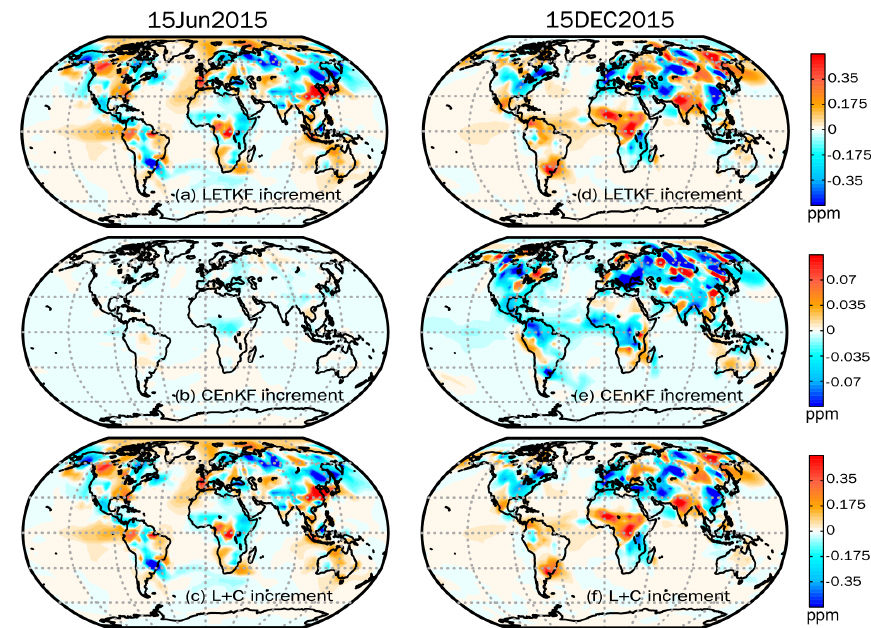
Figure 12. The ensemble mean LETKF and CEnKF increments of the surface CO 2 on 15 June 2015 (a–c) and 15 December 2015 (d–f) for